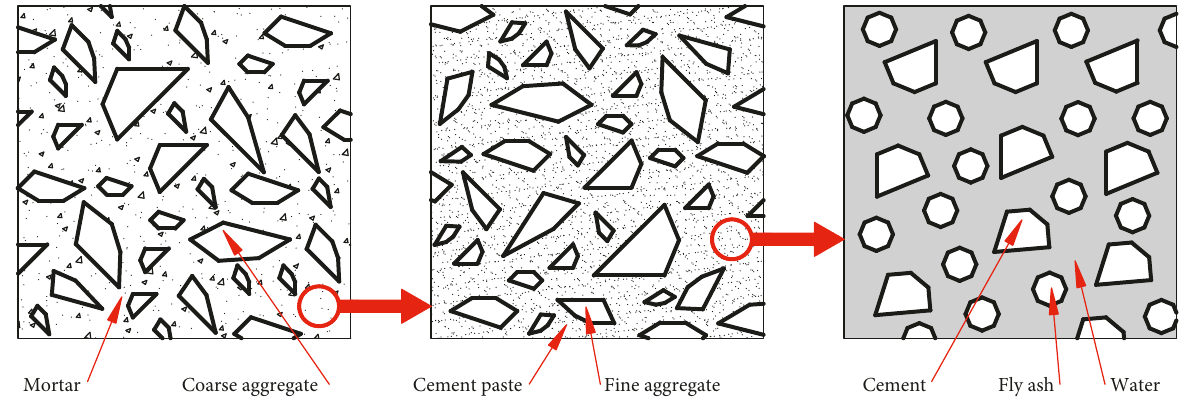
Figure 5: The aggregate space model for